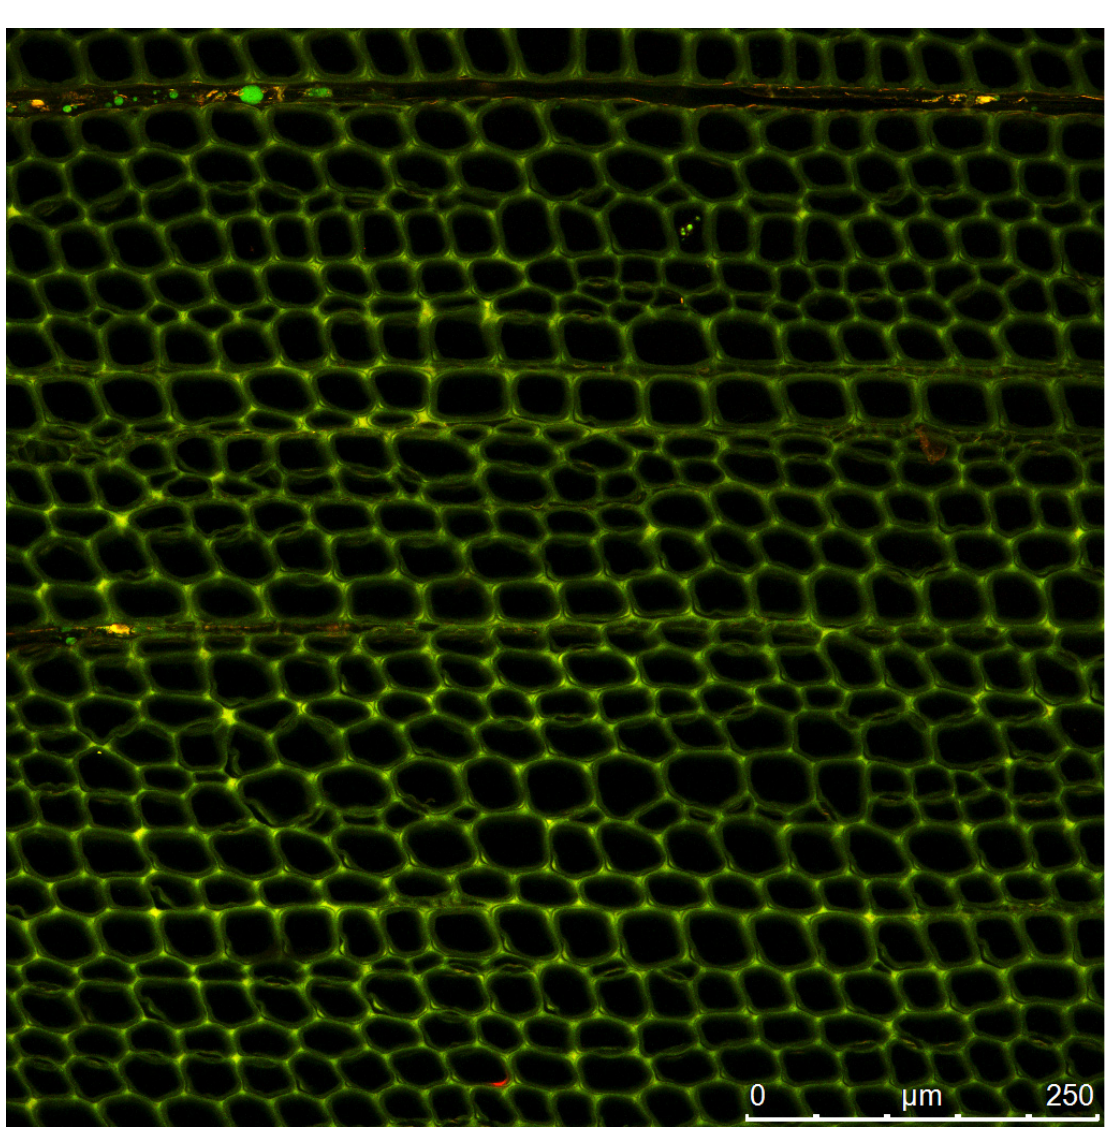
Figure 11. Autofluorescence of untreated wood cells under optical microscope.